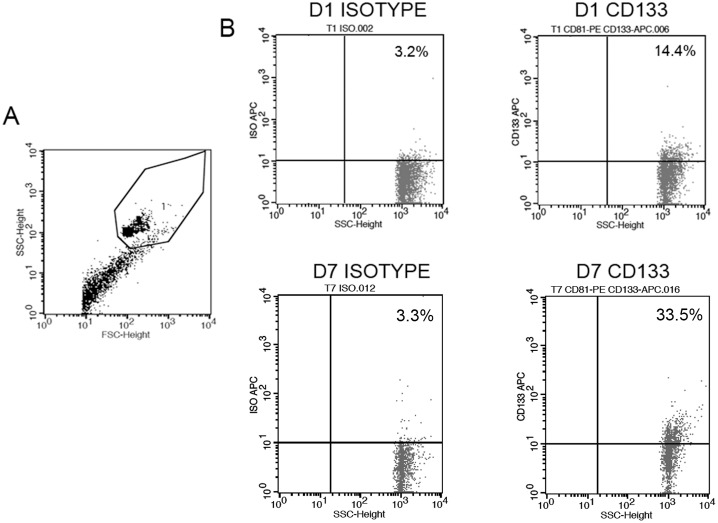
Detection of CD133+ EVs in transplanted patients.Panel A and B. Representative dot plots showing the gating strategy of latex bead-conjugated EVs (A) and the fluorescence detection of isotype or CD133 on EVs from a transplanted patients at day 1 or 7.